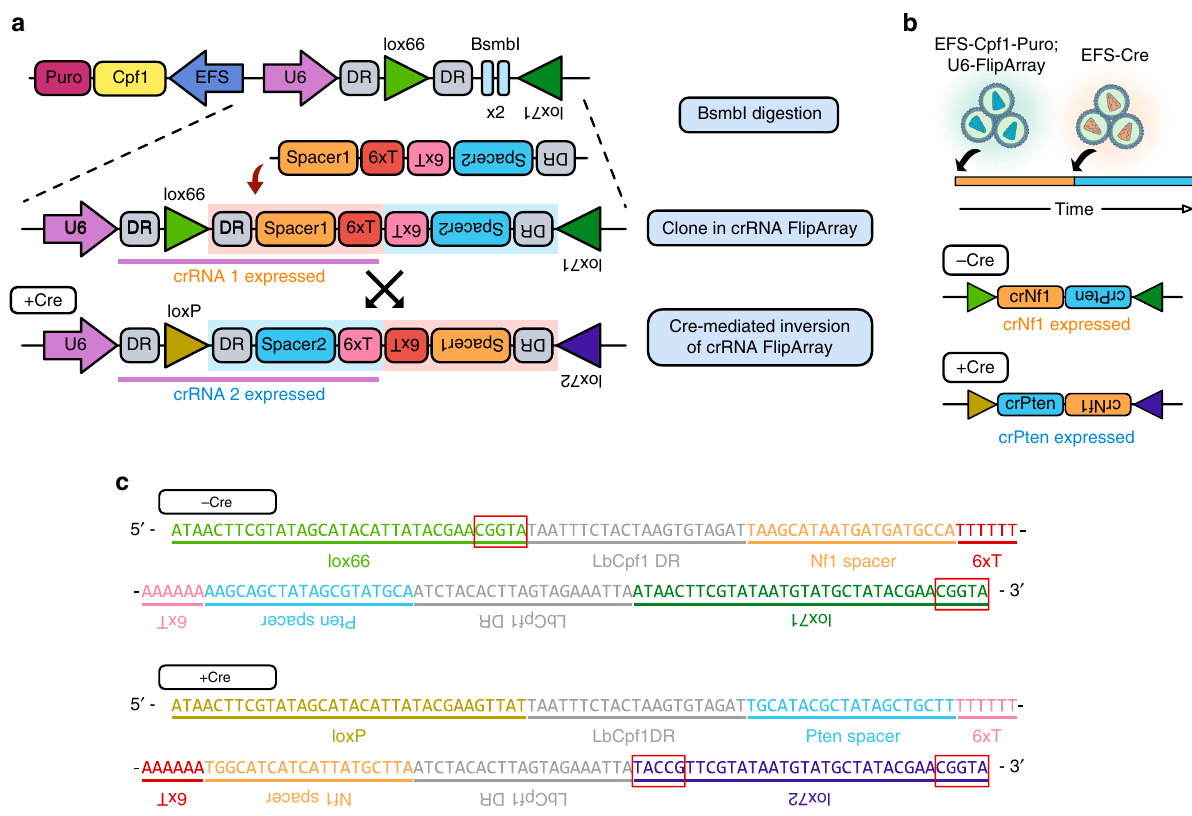
Fig. 1 Cpf1 – Flip – Cre-inducible sequential mutagenesis by a single crRNA FlipArray. a Schematic of vectors used in the study. The Cpf1-Flip construct contains an EFS promoter driving expression of Cpf1 and puromycin resistance, and a U6 expression cassette containing two inverted BsmbI restriction sites, fl anked by a lox66 sequence and an inverted lox71 sequence. After BsmbI digestion, a crRNA FlipArray is cloned in. The FlipArray inverts upon Cre recombination, thereby switching the crRNA that is expressed. b Schematic of experimental design. Cells were fi rst infected with lentivirus containing EFS-Cpf1-puro; U6-FlipArray. After 7 days, cells were then infected with lentivirus containing EFS-Cre to induce inversion of the FlipArray. Prior to Cre recombination, only crNf1 is expressed; following Cre recombination, crPten becomes expressed. c Sequences of the FlipArray construct before and after Cre recombination. Red boxes denote mutants from wild-type loxP . Prior to Cre, single mutant lox66 and lox71 sites are present. After Cre recombination, a wild-type loxP site and a double mutant lox72 site are